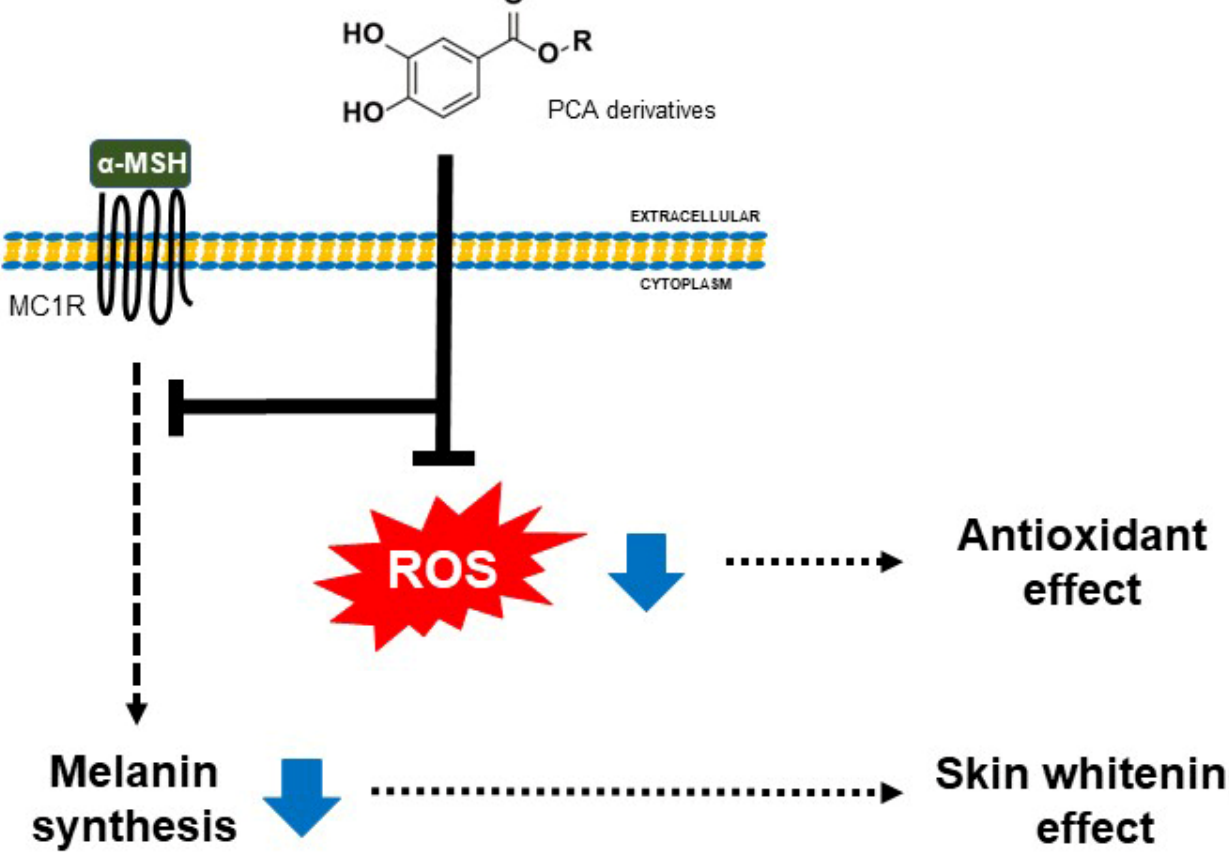
Figure 4. A simple scheme of anti-melanogenesis and antioxidant effects exerted by PCA derivatives. The anti-whitening effect of PCA derivatives is mediated by inhibiting the melanin synthesis induced via α -melanocyte-stimulating hormone ( α -MSH) in B16 melanoma cells. In addition, PCA derivatives have a more effective antioxidant effect than PCA in HS68 fibroblast cells. We suggest that PCA derivatives might have multiple effects for other needs.